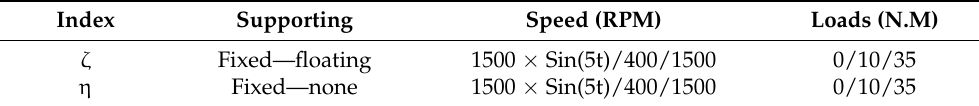
Table 3. The working condition of different